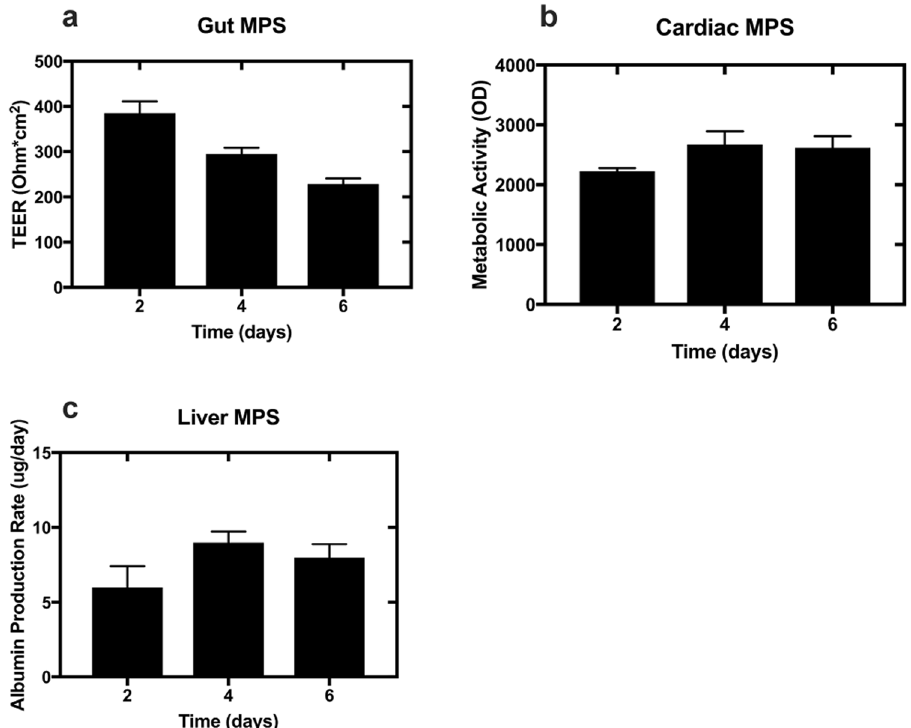
Figure 1. Assessment of MPS functionality without media change. The viability and functionality of gut MPS, cardiac MPS and liver MPS were assessed over six days without media change. ( a ) Gut MPS barrier integrity was monitored with TEER measurements. ( b ) Cardiac MPS viability was assessed with metabolic activity measurements using PrestoBlue. ( c ) Liver MPS functionality was assessed by albumin production rate. Error bars are standard deviation of triplicate MPSs for each time